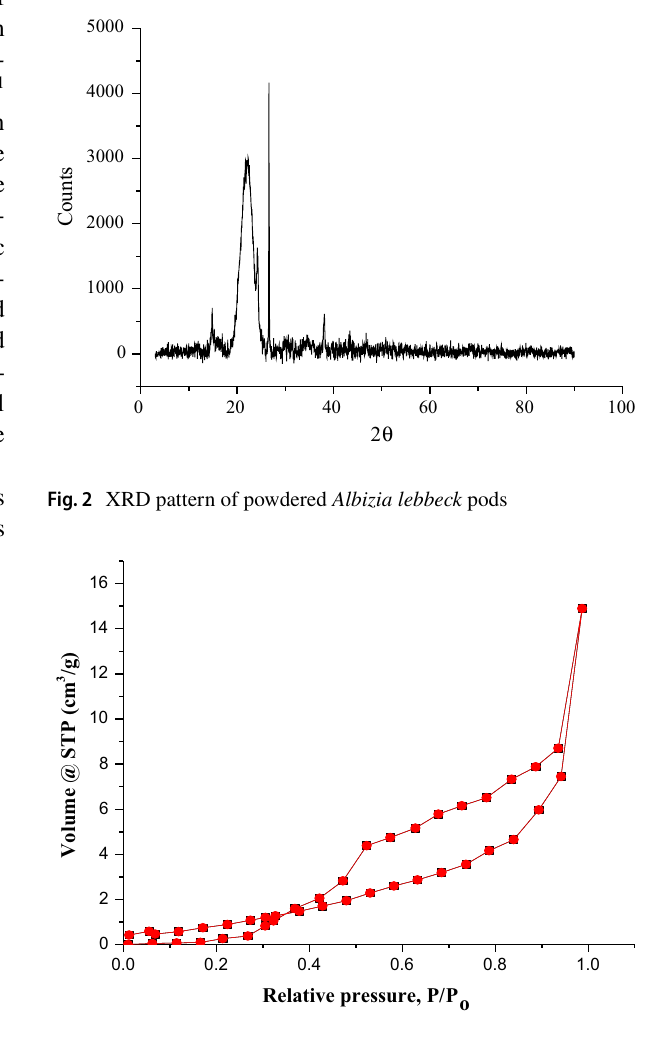
Fig. 1 FTIR analysis for Albizia lebbeck pod